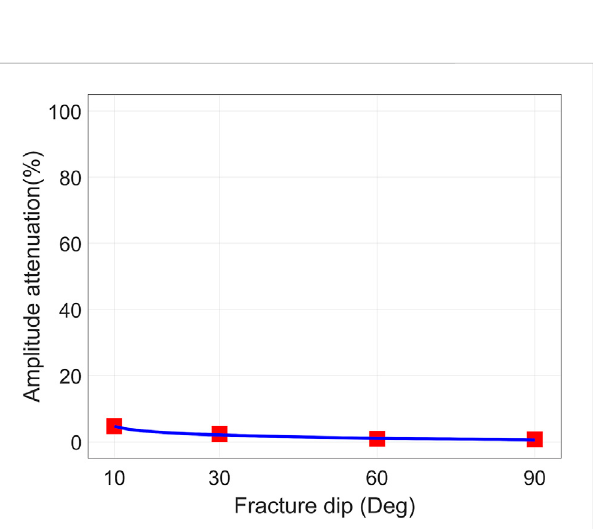
FIGURE 11 Amplitude attenuation of dipole S wave versus different fracture dip angles. The fracture width is 40 mm and fi lled with